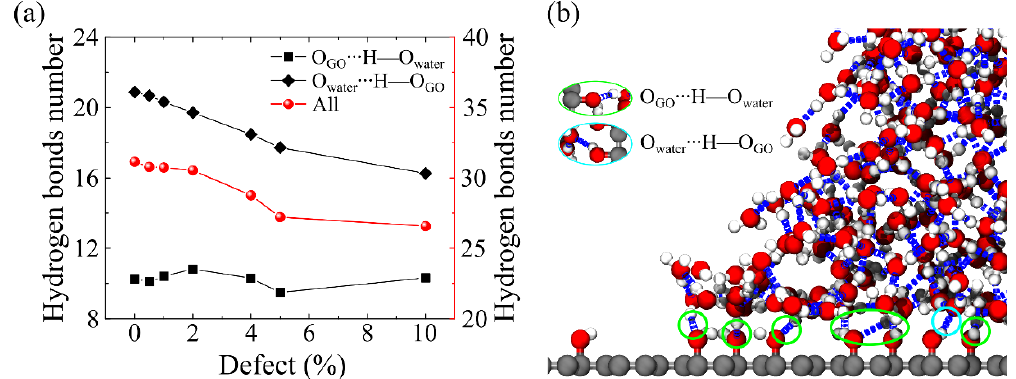
Figure 6. ( a ) Evolution of the number of hydrogen bonds on the liquid–solid interface with defect concentrations. The two black dotted lines represent the number of hydrogen bonds of the donor (bottom line) and acceptor of water molecules (top line). The red dotted line represents the sum of the number of hydrogen bonds between them. ( b ) The schematic diagram of the formation of hydrogen bonds at the liquid–solid contact line. The green circle emphasizes the hydrogen of the donor water molecules, and the cyan circle emphasizes the hydrogen of the acceptor water molecules.